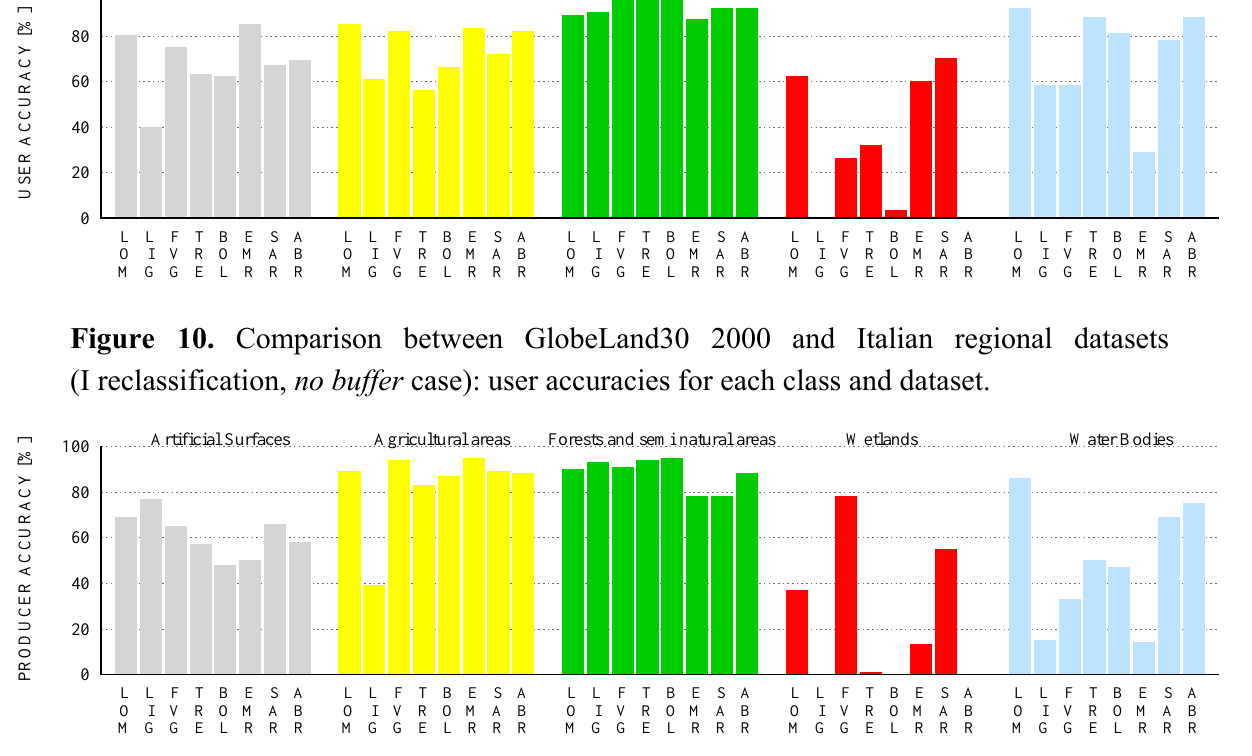
Figure 11. Comparison between GlobeLand30 2000 and Italian regional datasets (I reclassification, no buffer case): producer accuracies for each class and